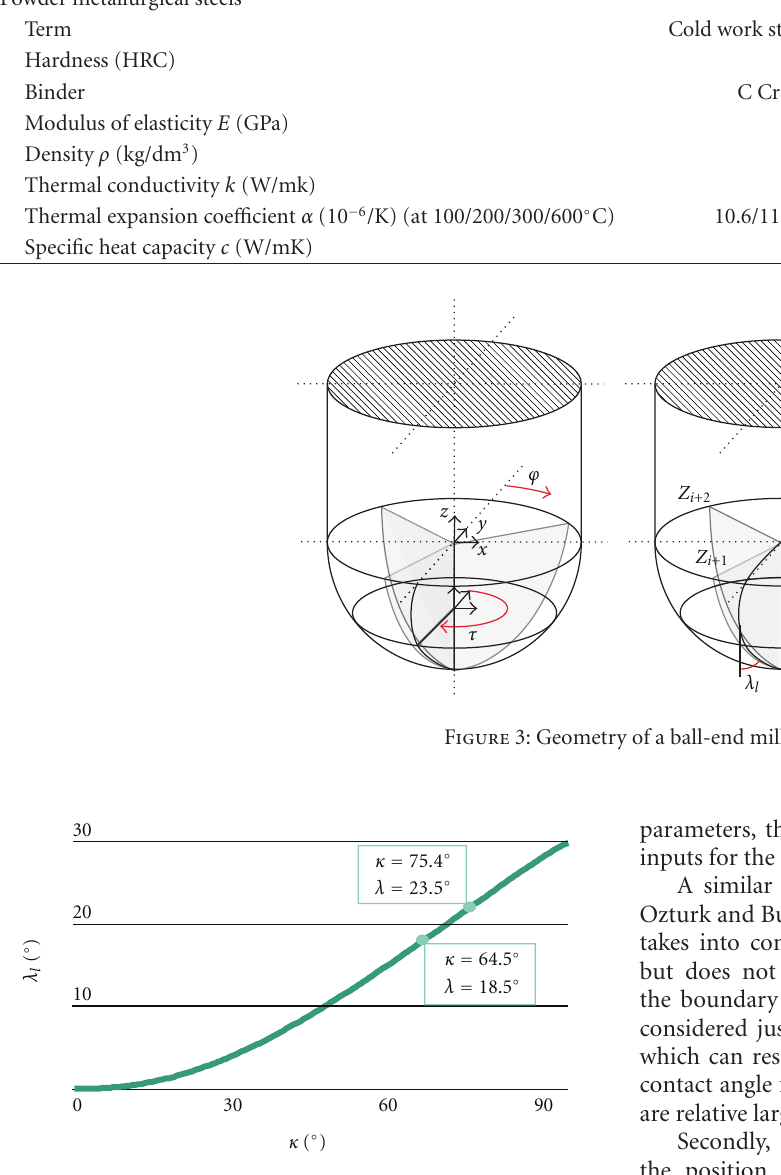
Figure 4: Variation of the local helix angle λ l with the axial immersion angle κ